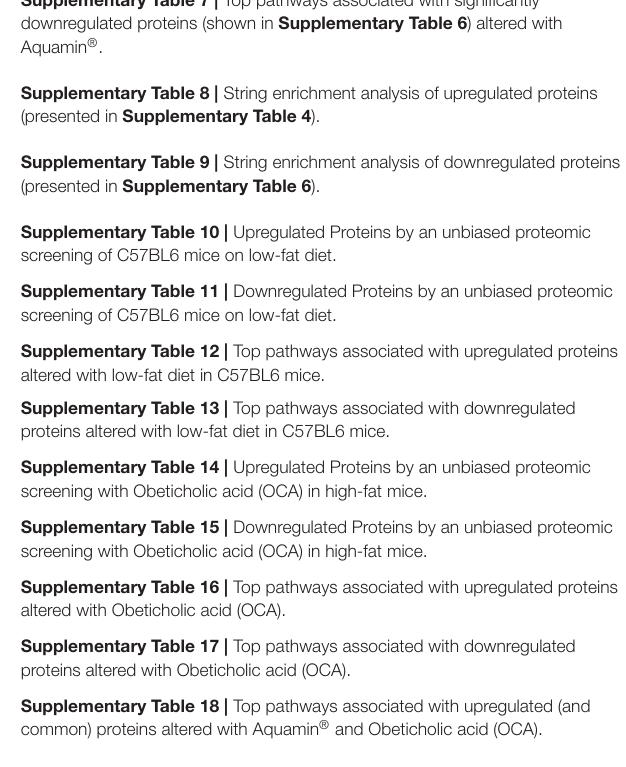
Supplementary Table 6 | Comprehensive list of downregulated (and significantly altered) proteins with Aquamin ® in high-fat mice. Supplementary Table 7 | Top pathways associated with significantly downregulated proteins (shown in Supplementary Table 6 ) altered with Aquamin ® . Supplementary Table 8 | String enrichment analysis of upregulated proteins (presented in Supplementary Table 4 ). Supplementary Table 9 | String enrichment analysis of downregulated proteins (presented in Supplementary Table 6 ).